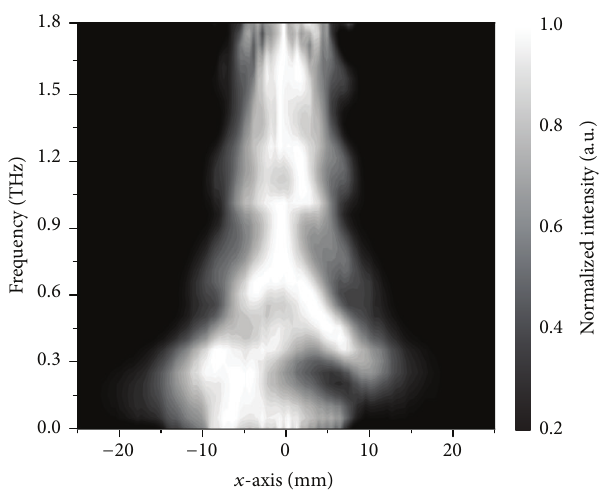
Figure9:MeasurementoftheTHzradiationpatternforLT-GaAsas emitter on HR-Si substrate with a spectral bandwidth up to 1.8THz at a distance of 65 mm in 𝑧